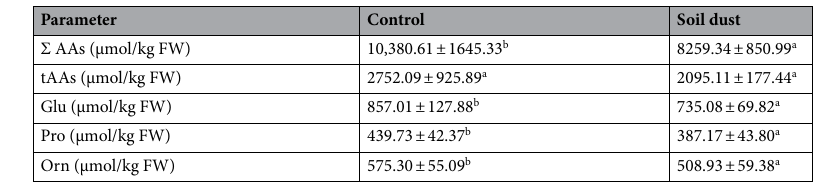
Table 3. Content of selected free amino acids in the lettuce leaves of the control and soil dust treatments. Σ AAs: total content of free amino acids, tAAs: sum of transport and storage free amino acids, Glu: free glutamine, Pro: free proline, Orn: free ornithine. Values are means ± SD. Lower-case letters indicate significant differences based on Fisher’s LSD test ( p ≤ 0.05). Data with the same letter are not significantly